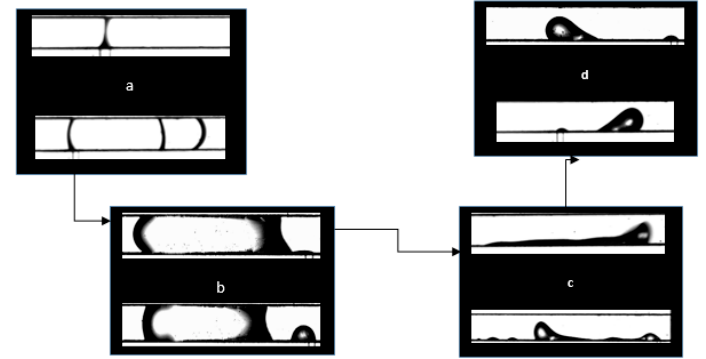
Figure6. Representativeimagesoftwo-phaseflowstructures: ( a )liquidwaterbridge / plug, ( b )slug / plug, Figure 6. Representative images of two-phase flow structures: ( a ) liquid water bridge/plug, ( b ) ( c ) film flow, and ( d ) droplet slug/plug, ( c ) film flow, and ( d ) droplet flow.